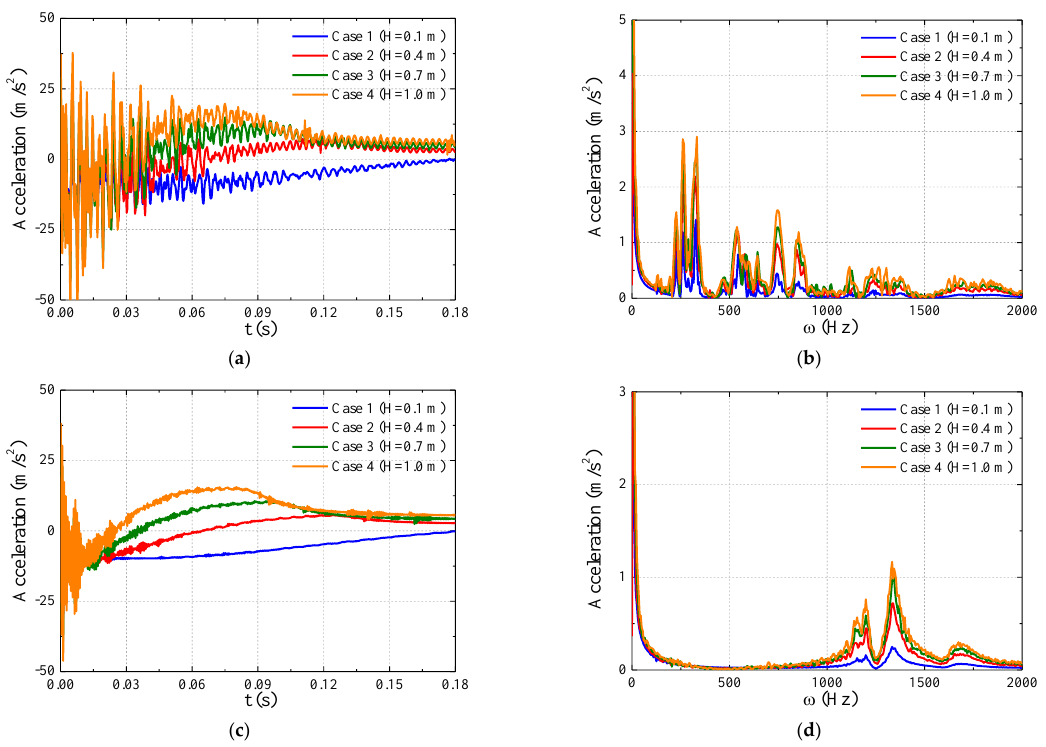
Figure 29. Vertical acceleration at different cases (at Point S2): ( a ) time series for 6-DOF released; ( b ) spectra for 6-DOF released; ( c ) time series for 1-DOF released; ( d ) spectra for 1-DOF released.